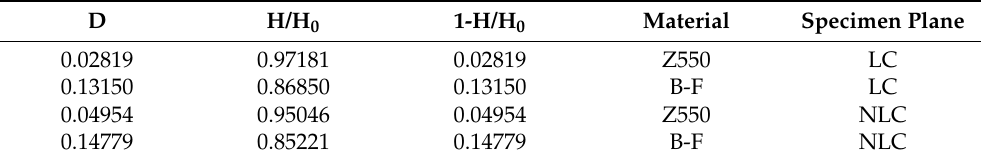
Table 6. Changes in the microhardness of the test materials after aging in artificial saliva (AS) for 26 months. LC—light-cured surface of sample (the top side of a sample), NLC—non-light-cured surface (the bottom side of a sample), HK—Knoop